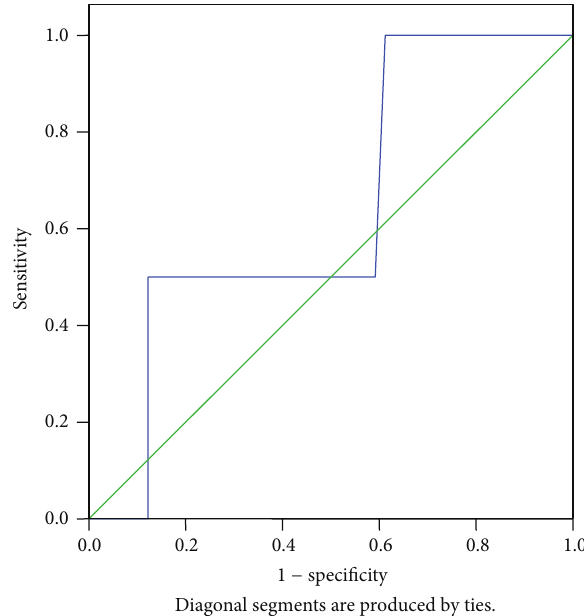
Figure 1: ROC curve for low maternal serum magnesium level ( > 1.6mg/dL) and preterm